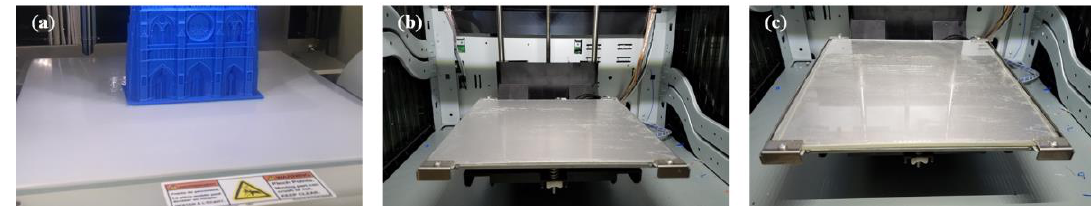
Figure 3. Common standard FDM build plate configurations ( a ) non-heated tempered glass; ( b ) heated aluminum; and ( c ) tempered glass and aluminum composite.